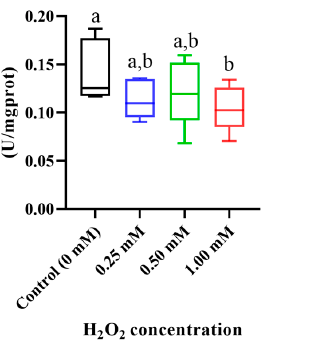
Figure 5. Activities of Na + /K + -ATPase ( A ), Ca 2+ /Mg 2+ -ATPase ( B ), and H + /K + -ATPase ( C ) in gills of